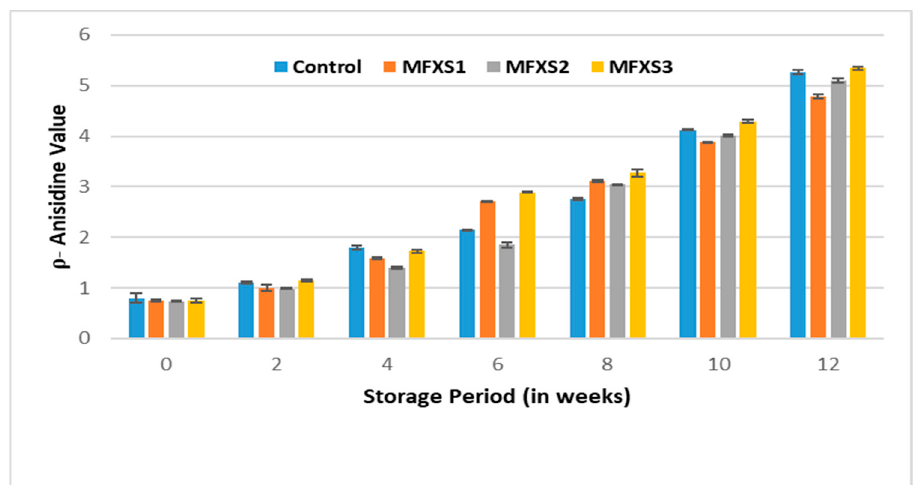
Figure 7. Anisidine value of mayonnaise samples during ambient storage (25 ± 5 °C). Control sample: 70% soy bean oil, MFXS1: 20% flaxseed oil and 50% soy bean oil, MFXS2: 30% flaxseed oil and